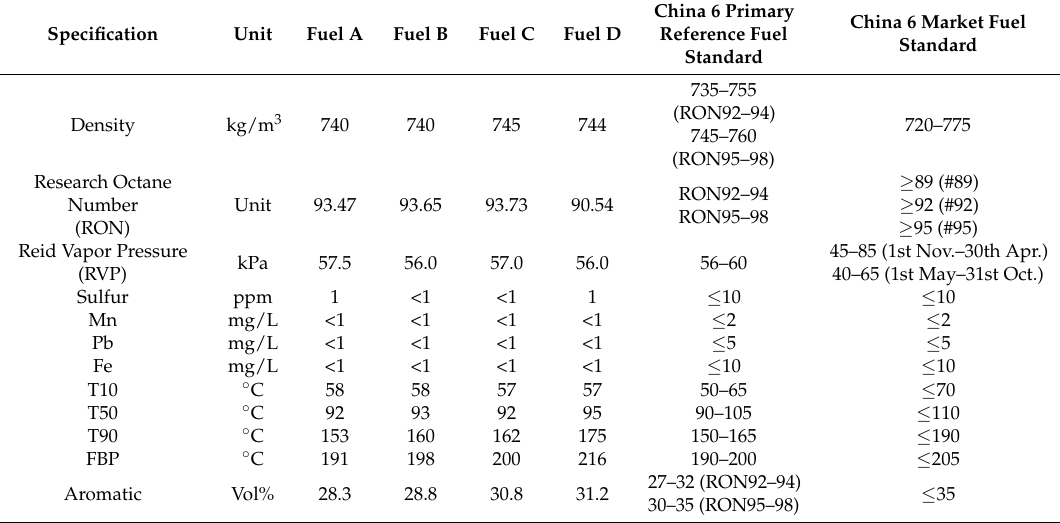
Table 1. Key specifications for test fuels, China 6 primary reference fuel and market fuel standards.